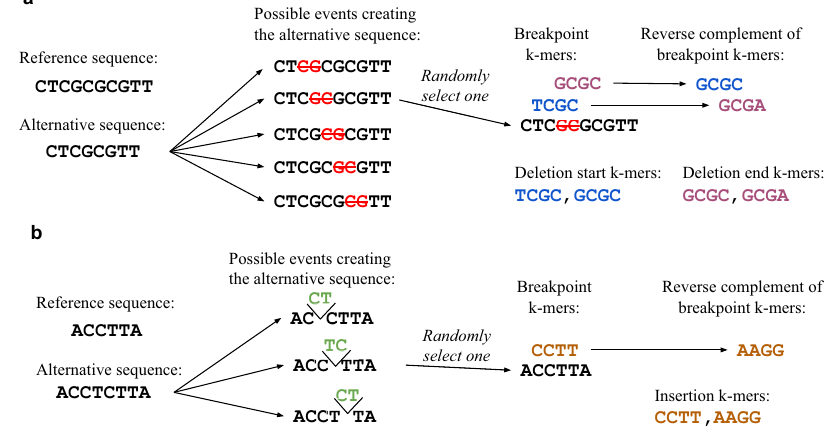
Fig. 3 | Counting k-mers for indels. The exact positions of indels are often inde- terminable based on the sequence data. To handle this we enumerate all possible events creating the alternative sequenceand selectone ofthem atrandom. We do thisindependently foreachindelmutation.Unlikepoint mutations, wecountboth